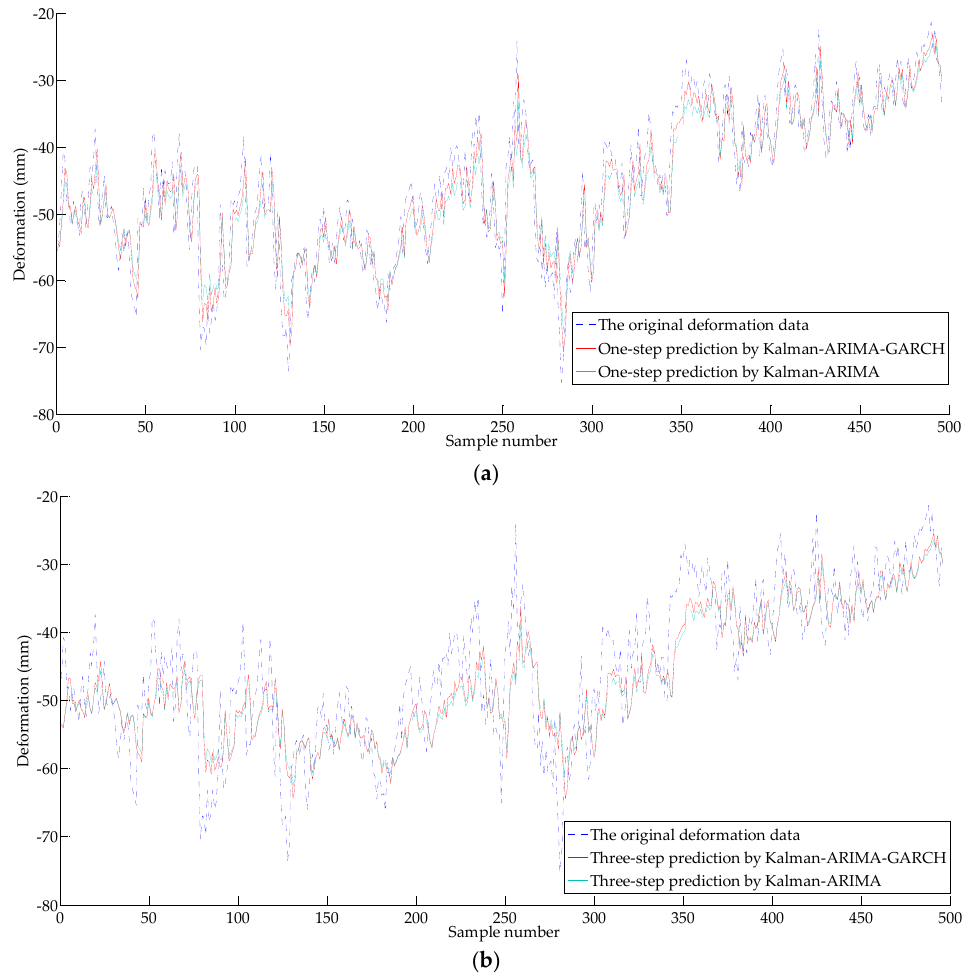
Figure 11. Results of the predictions for the original deformation series {X 2t } by the ARIMA and the autoregressive conditional heteroscedasticity model (GARCH): ( a ) One-step prediction; ( b ) Three-step prediction.